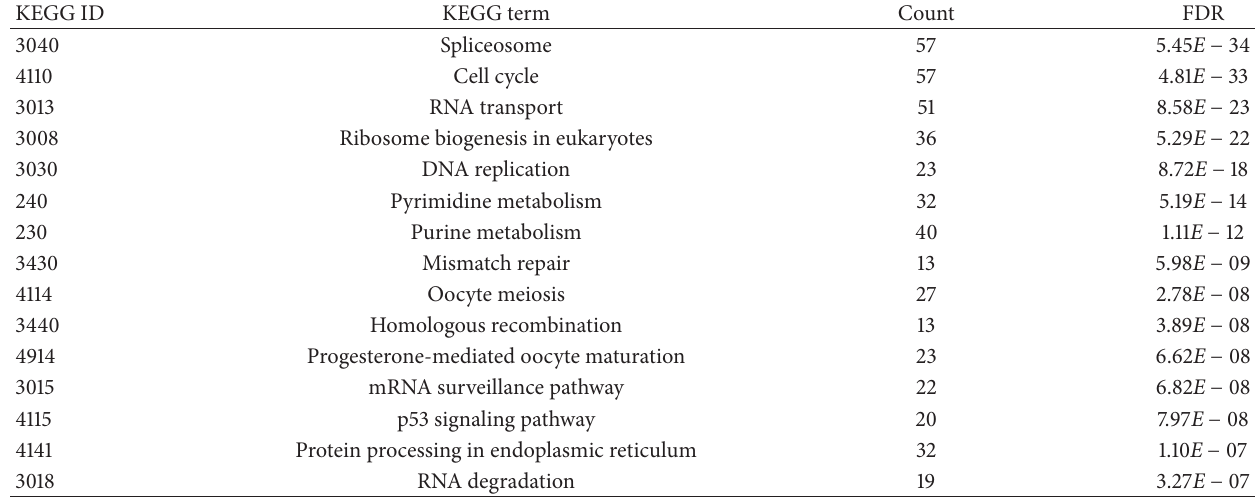
Table 4: Top 15 enriched KEGG pathways of DEGs between gastric cancer and normal